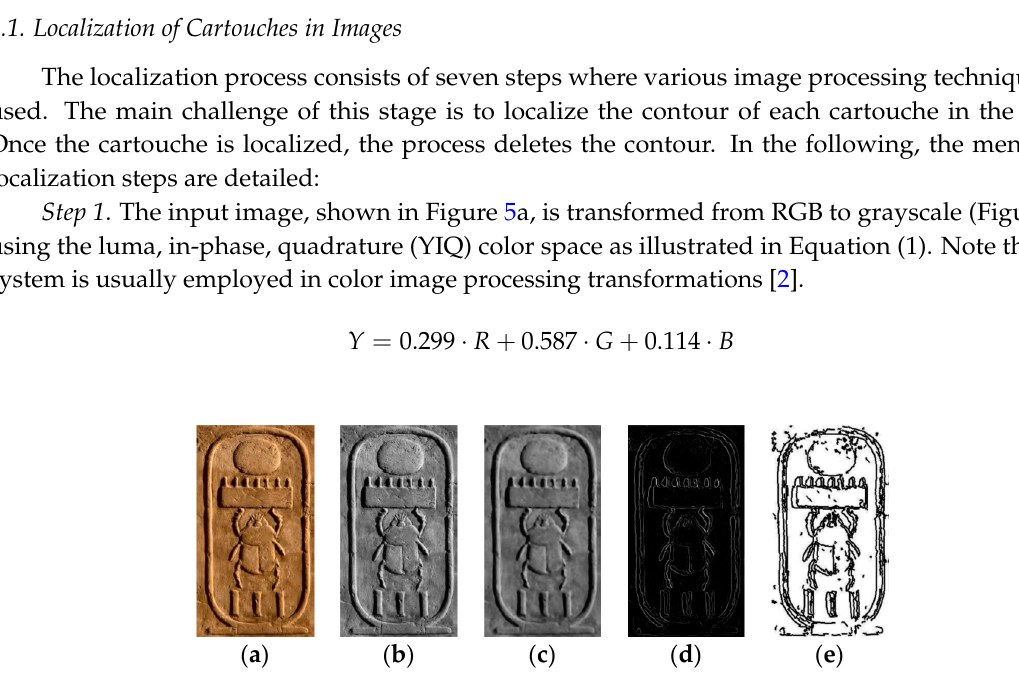
Figure 6. ( a ) Original image; ( b ) Longest border of the cartouche; ( c ) Cartouche after orientation correction; ( d ) Recognition of the cartouche borders; ( e ) Extraction of the regions of interest.